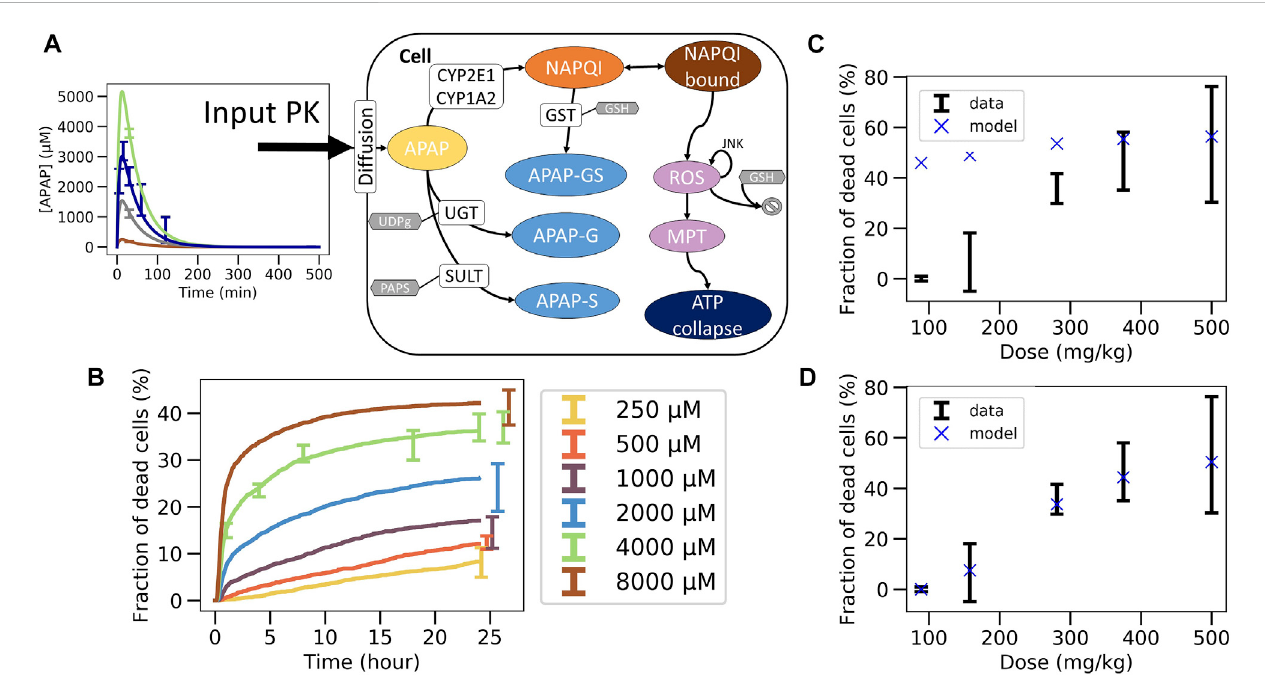
FIGURE 4 Non-coupled PK/PD model strategy. (A) Scheme of the APAP metabolic model where the PK model is plugged as an input, (B) best fi t on in vitro toxicity data over 40 different random seeds (shown is a particular seed, label 13), extrapolation to in vivo fraction of dead cells after correcting CYP enzyme activity and GSH concentration with (C) same permeability in vitro and in vivo (D) and with lower permeability in vivo